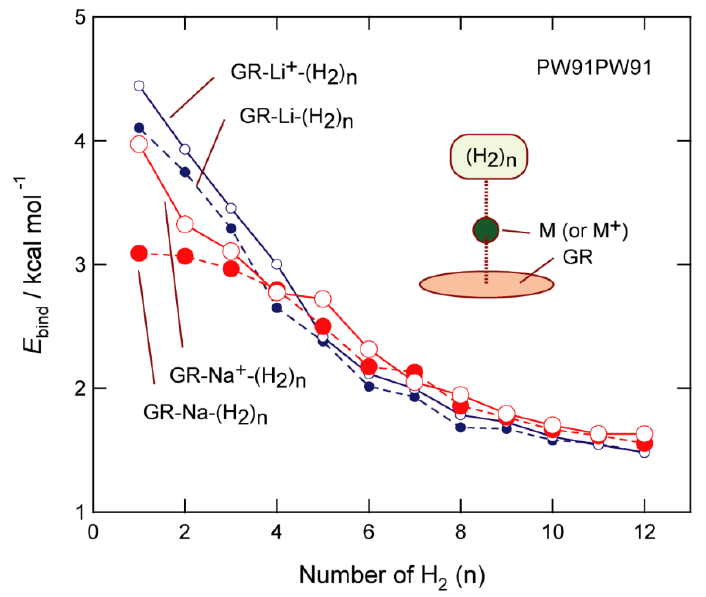
Figure 7. Functional dependency of the H 2 – GR-Li + (Na + ) binding energy (per H 2 molecule). Calculations were performed at the PW91PW91/6-311G(d,p) level.